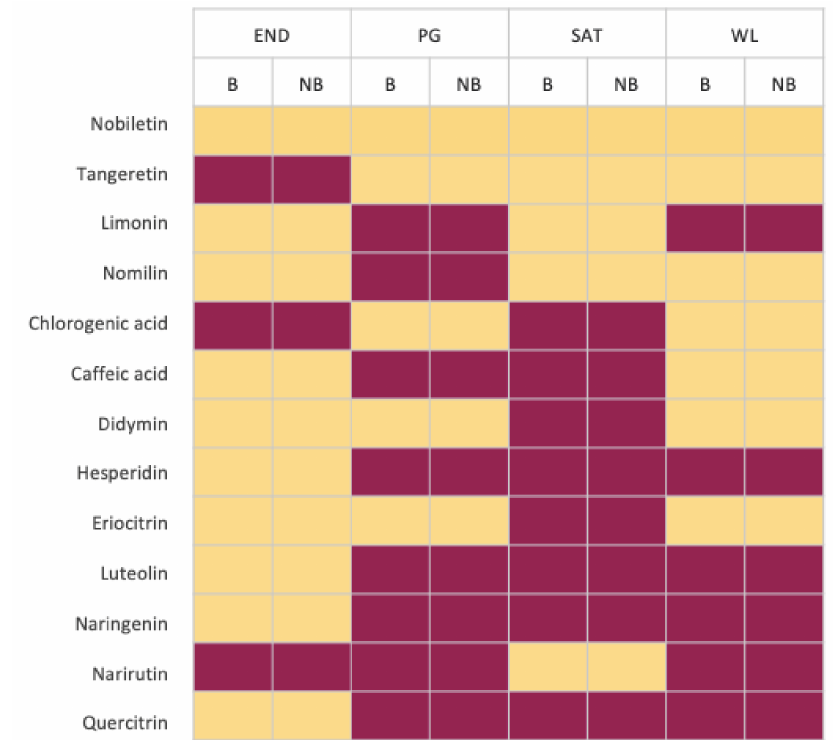
Figure 4. Visual representation of Wilcoxon test for determination of significant differences between bearing and non-bearing stages, for each compound and each variety. References: ‘Ellendale’ (END), ‘Page’ (PG), ‘Satsuma’ (SAT), ‘Willowleaf’ (WL), bearing stage (B), non-bearing stage (NB), means does not differ significantly using Wilcoxon test, p ≤ 0.05, and means differs significantly using Wilcoxon test, p ≤ 0.05.